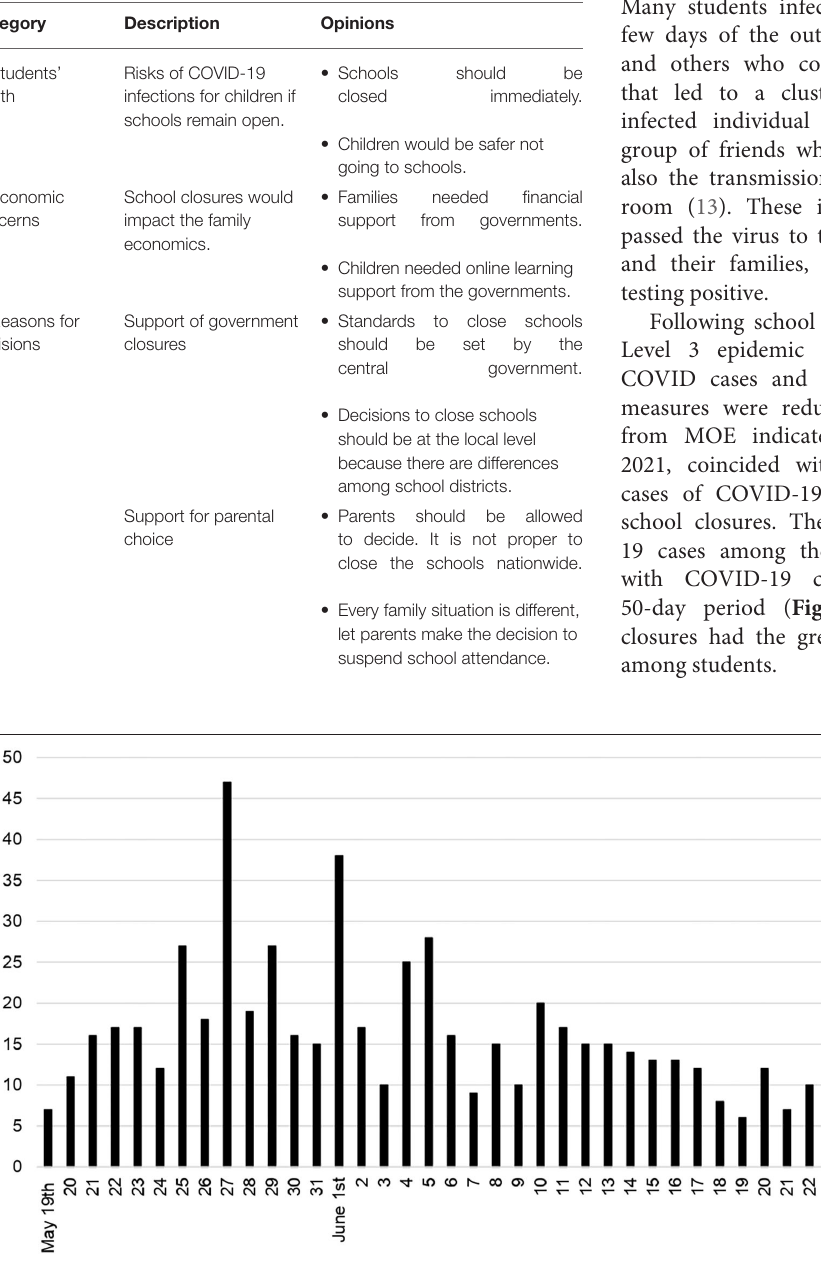
Frontiers in Public Health |